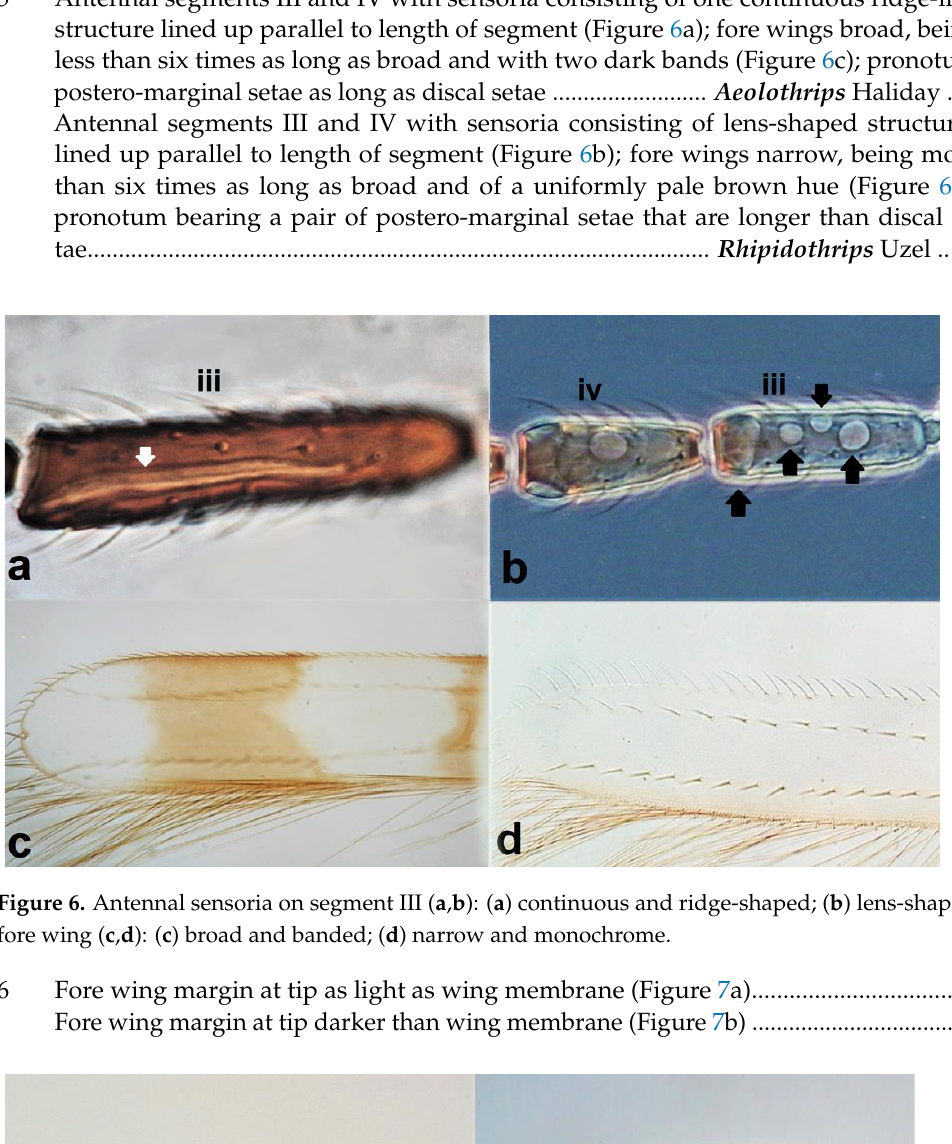
Antennal segments III and IV with sensoria consisting of one continuous ridge-like structure lined up parallel to length of segment (Figure 6a); fore wings broad, being less than six times as long as broad and with two dark bands (Figure 6c); pronotum postero-marginal setae as long as discal setae ......................... Aeolothrips Haliday .. 6 Antennal segments III and IV with sensoria consisting of lens-shaped structures lined up parallel to length of segment (Figure 6b); fore wings narrow, being more than six times as long as broad and of a uniformly pale brown hue (Figure 6d); pronotum bearing a pair of postero-marginal setae that are longer than discal se-